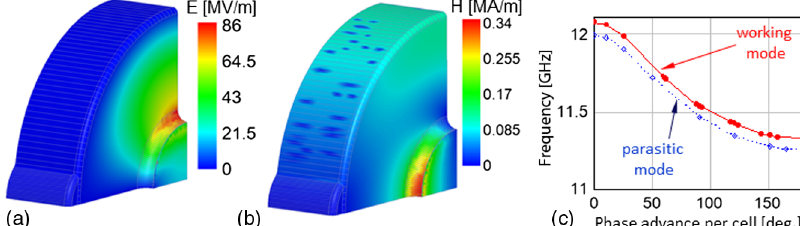
FIG. 2. Periodic eigen-solution for regular cell of the rf deflector: (a) surface electric fields; (b) surface magnetic fields; (c) dispersion curves for both working and parasitic modes of orthogonal polarization, with about 100 MHz separation between the curves. Detailed parameters of the cell are listed in Table III.